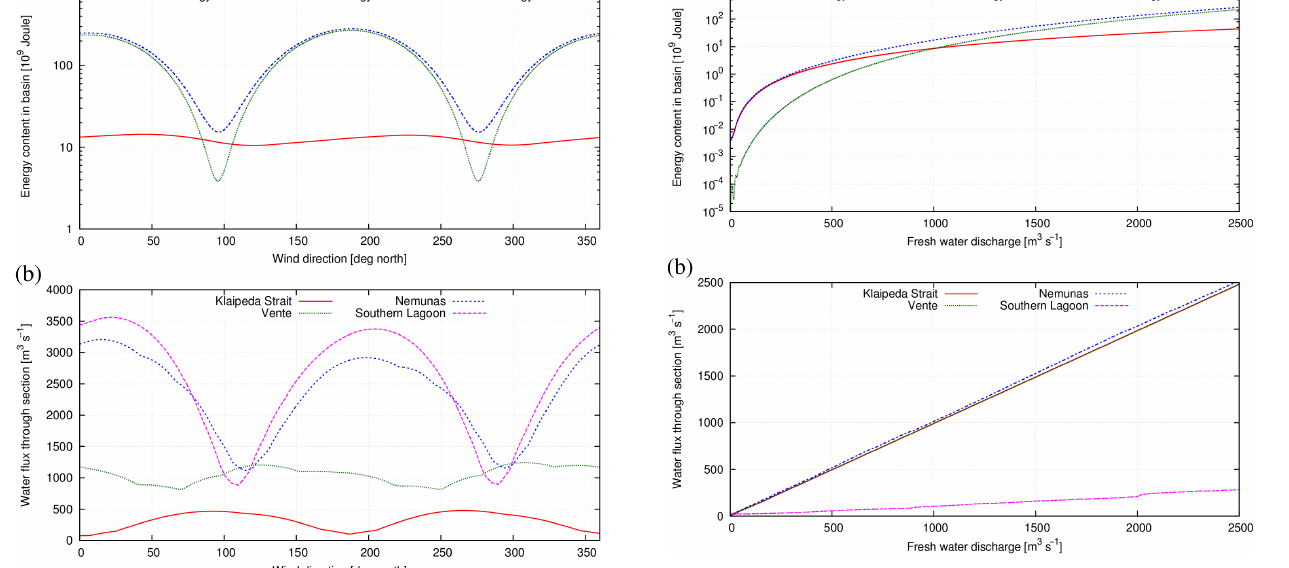
Figure 3. Energy content in basin (a) and fluxes through selected sections (b) depending on the wind direction. For the location of the sections see Fig. 1.